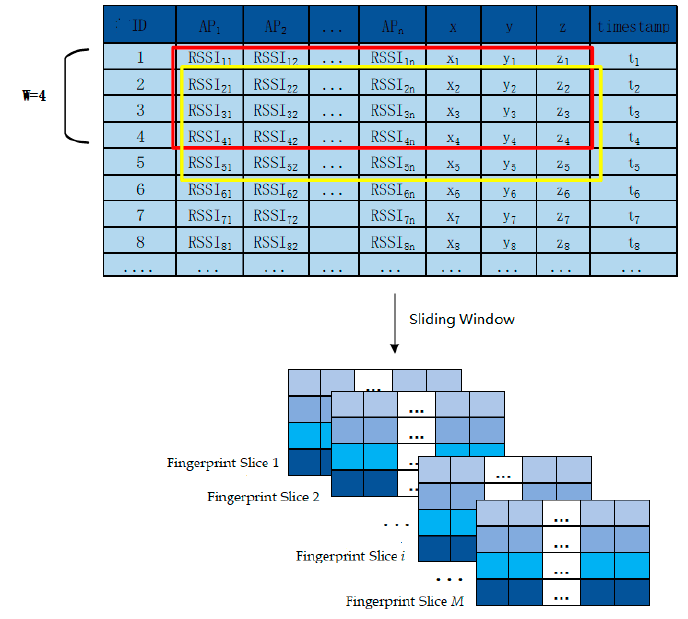
Figure 4. Fingerprint slice construction process.